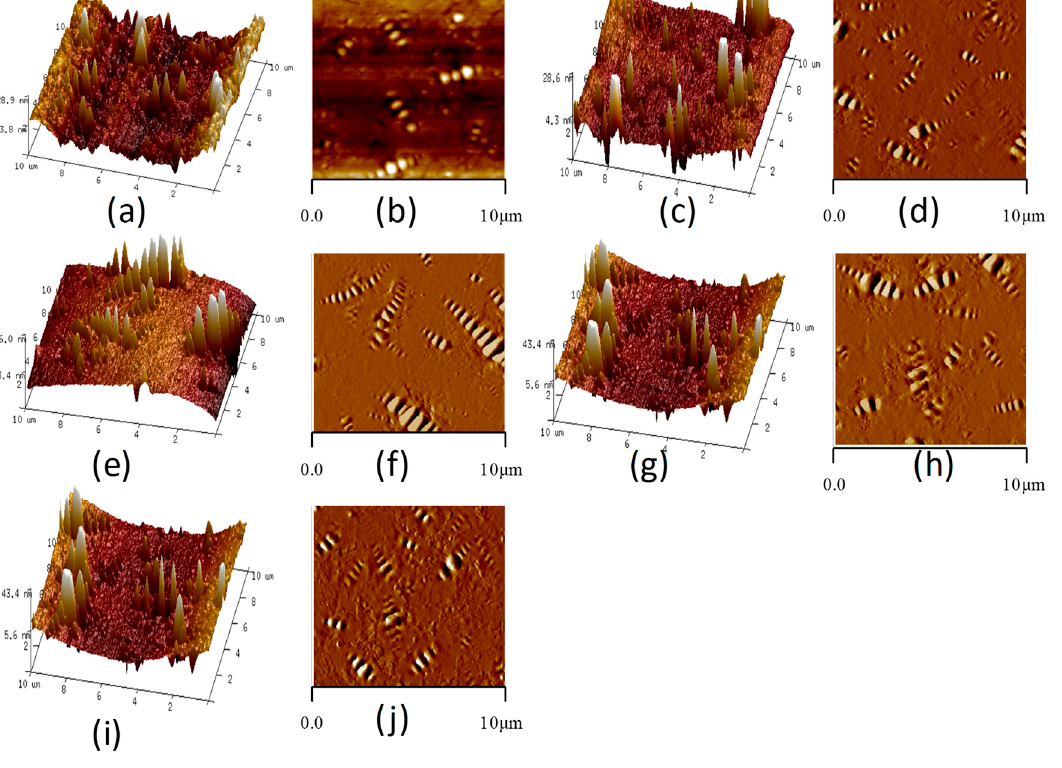
Figure 4. AFM images of bitumen with di ff erent SBS content ( a , c , e , g , i are the three-dimensional height images, the content of SBS are 0, 3%, 4%, 5%, and 6%, respectively; b , d , f , h , j are the two-dimensional height images, the content of SBS are 0, 3%, 4%, 5%, and 6%, respectively).